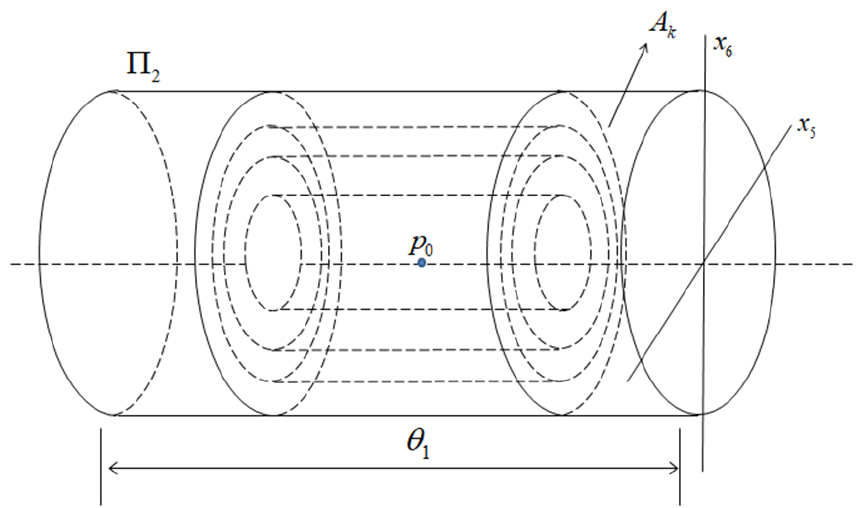
Figure 8. The three-dimensional torus structure Π 2 and the nested solid ring structure. The behavior of boundary of k A under 2 needs to be investigated. The bound- ary of k A consists of the union of terminal linear structures at both ends, and also con- sists of a left terminal and a right terminal which are expressed as o S . The above terminal structures are ner and outer surfaces are marked as k